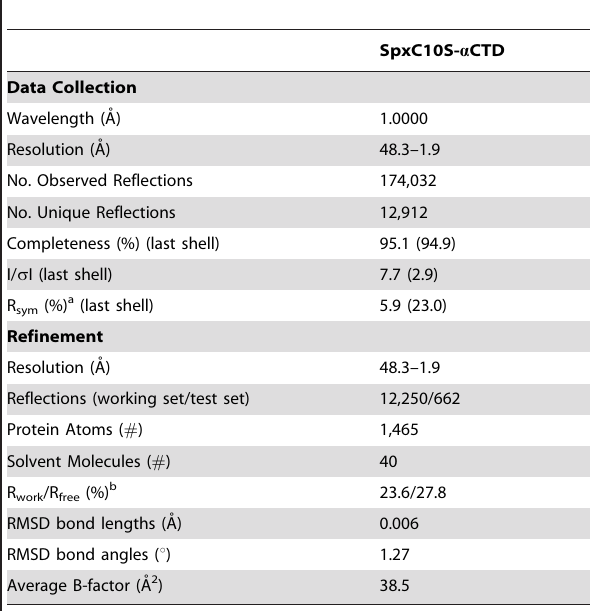
Table 1. Selected Crystallographic Data and